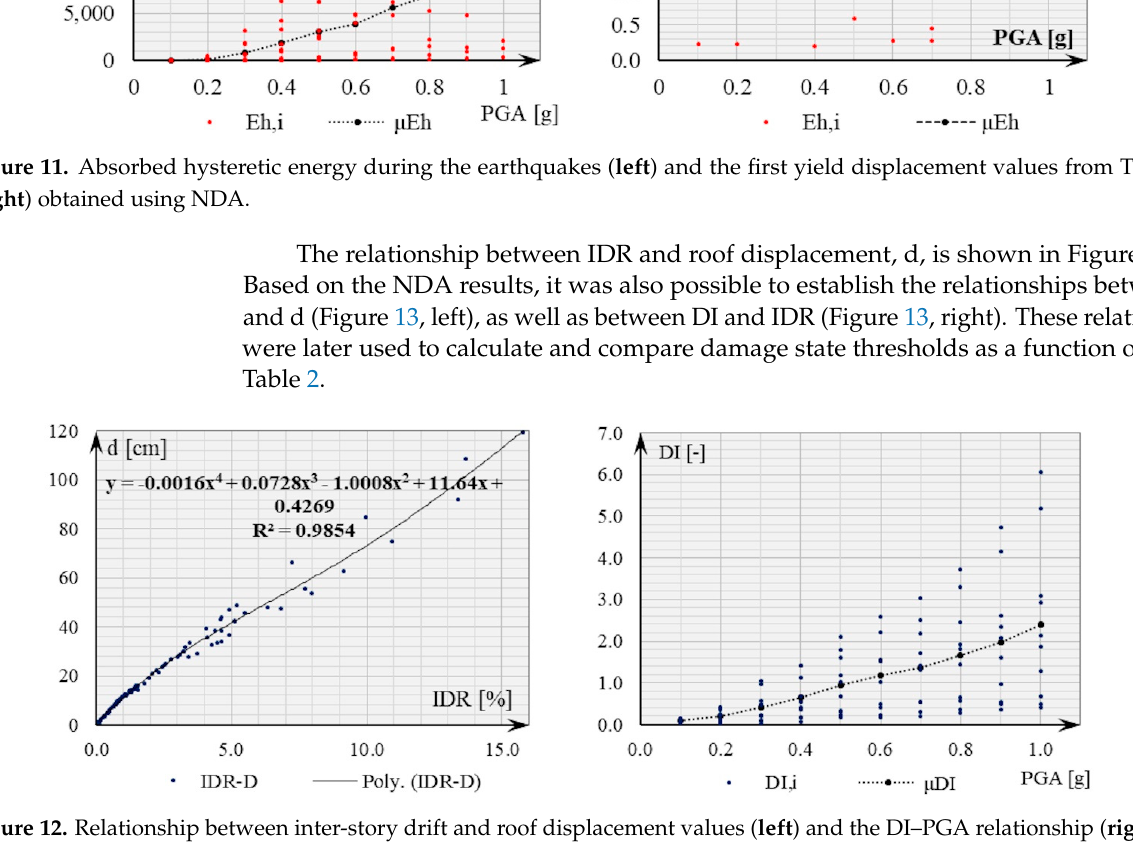
Figure 12. Relationship between inter-story drift and roof displacement values ( left ) and the DI–PGA relationship ( right ).